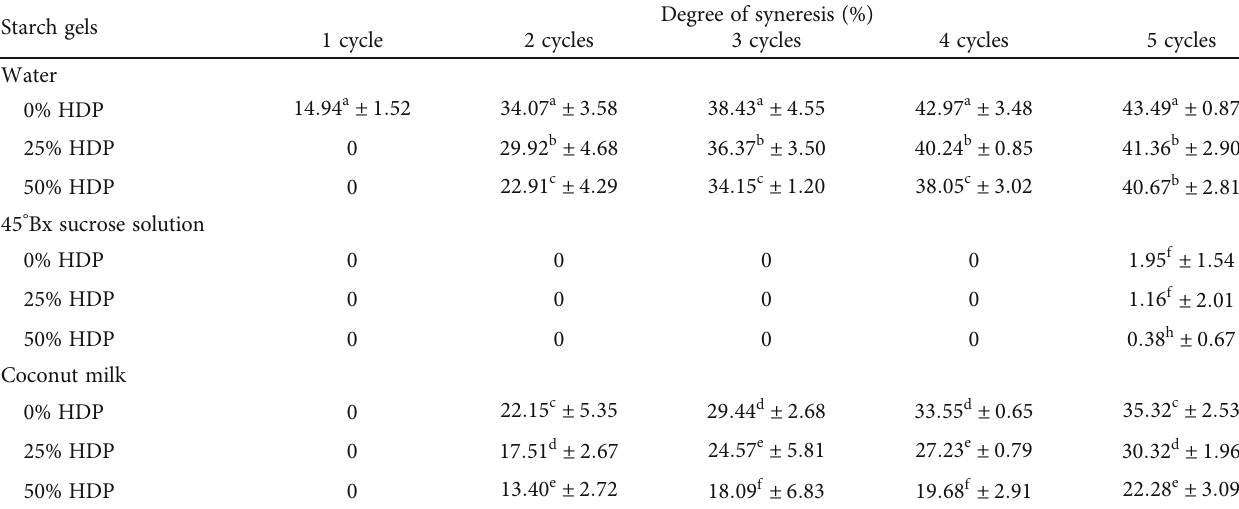
Table 1. HDP: hydroxypropylated distarch